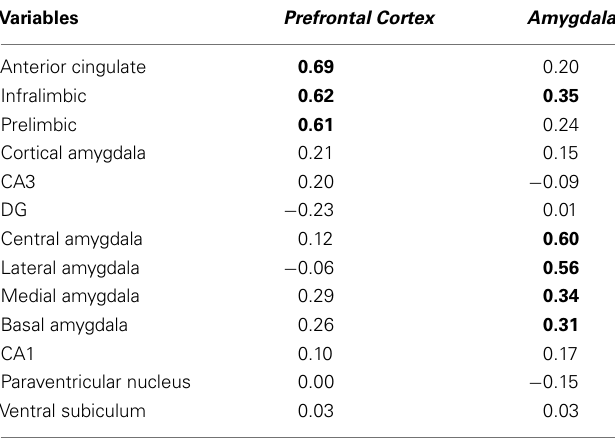
Table 2 | Component loadings for the predicted solution in